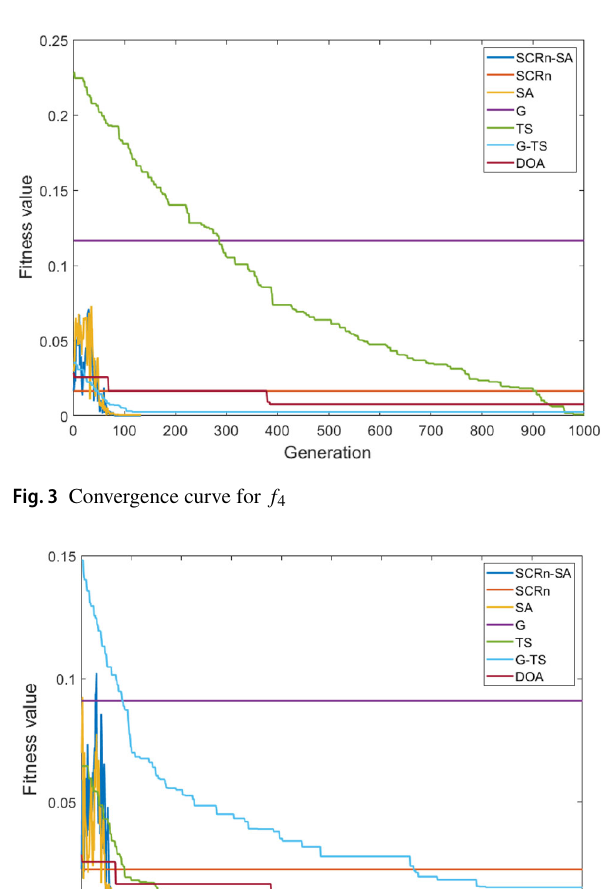
Fig. 2 Convergence curve for f 1